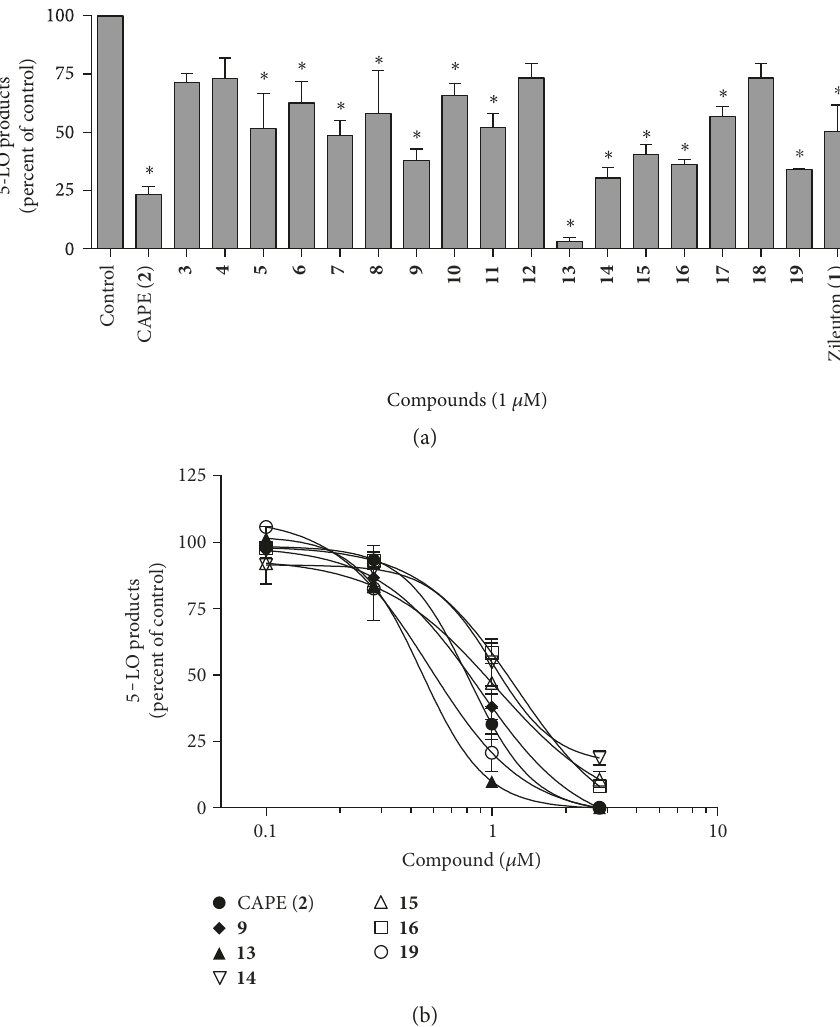
Figure 2: E ff ect of the test compounds on the biosynthesis of 5-LO products in transfected HEK293 cells (a) and thapsigargin-stimulated PMNL (b). (a) HEK293 cells expressing both 5-LO and FLAP were incubated in presence of the indicated compounds (1 μ M) or their diluent (control, 0.5% DMSO) for 5 min, then biosynthesis of 5-LO products was initiated with the addition of 10 μ M calcium ionophore A23187 and 10 μ M arachidonic acid for 15 min. After stimulation, reactions were stopped and samples were processed for analysis of 5-LO products by RP-HPLC. Total 5-LO products measured represent the sum of LTB , its trans isomers, and 5-hydroxyeicosatetraenoic 4 acid. (b) Freshly isolated human PMNL were incubated in presence of test compounds (or their diluent control, DMSO 0.5%) at the indicated concentrations for 5min. Biosynthesis of the 5-LO products was initiated with the addition of 1 μ M of thapsigargin, followed by a 15 min incubation period at 37 ° C. The stimulation was then stopped and samples were processed for RP-HPLC analysis and total 5-LO products quanti fi cation. Total 5-LO products measured represent the sum of LTB , its trans isomers, 20-COOH- and 20-OH-LTB and 4 4 5-hydroxyeicosatetraenoic acid. Data are expressed as means ± SEM of at least 3 independent experiments. ∗ Di ff erent from control, as determined by one-way ANOVA with Dunnett ’ s multiple comparison test ( p < 0 05